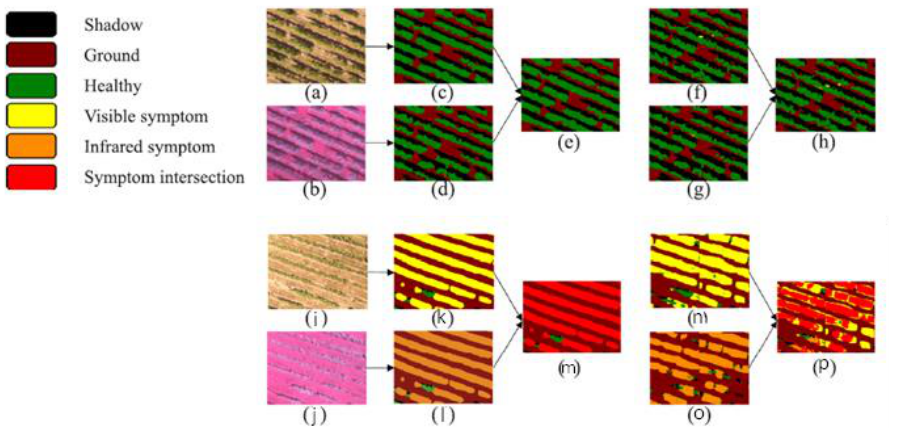
Figure 5. An illustration of segmenting and fusing a healthy region. Images in the following order: ( a ) visible image, ( b ) infrared image, ( c ) visible GT, ( d ) infrared GT, ( e ) fusion GT, ( f ) visible SegNet estimate, ( g ) infrared SegNet estimation, and ( h ) fusion of segmentation findings. An example of segmenting and fusing a mold-infested region. For example, ( i ) stands for visible image, ( j ) for infrared image, ( k ) for visible ground truth, ( l ) for infrared ground truth, ( m ) for fusion ground truth, ( n ) for visible segmentation net estimation, ( o ) for infrared segmentation net estimation, and ( p ) fusion of segmentation results (adapted from [25]).